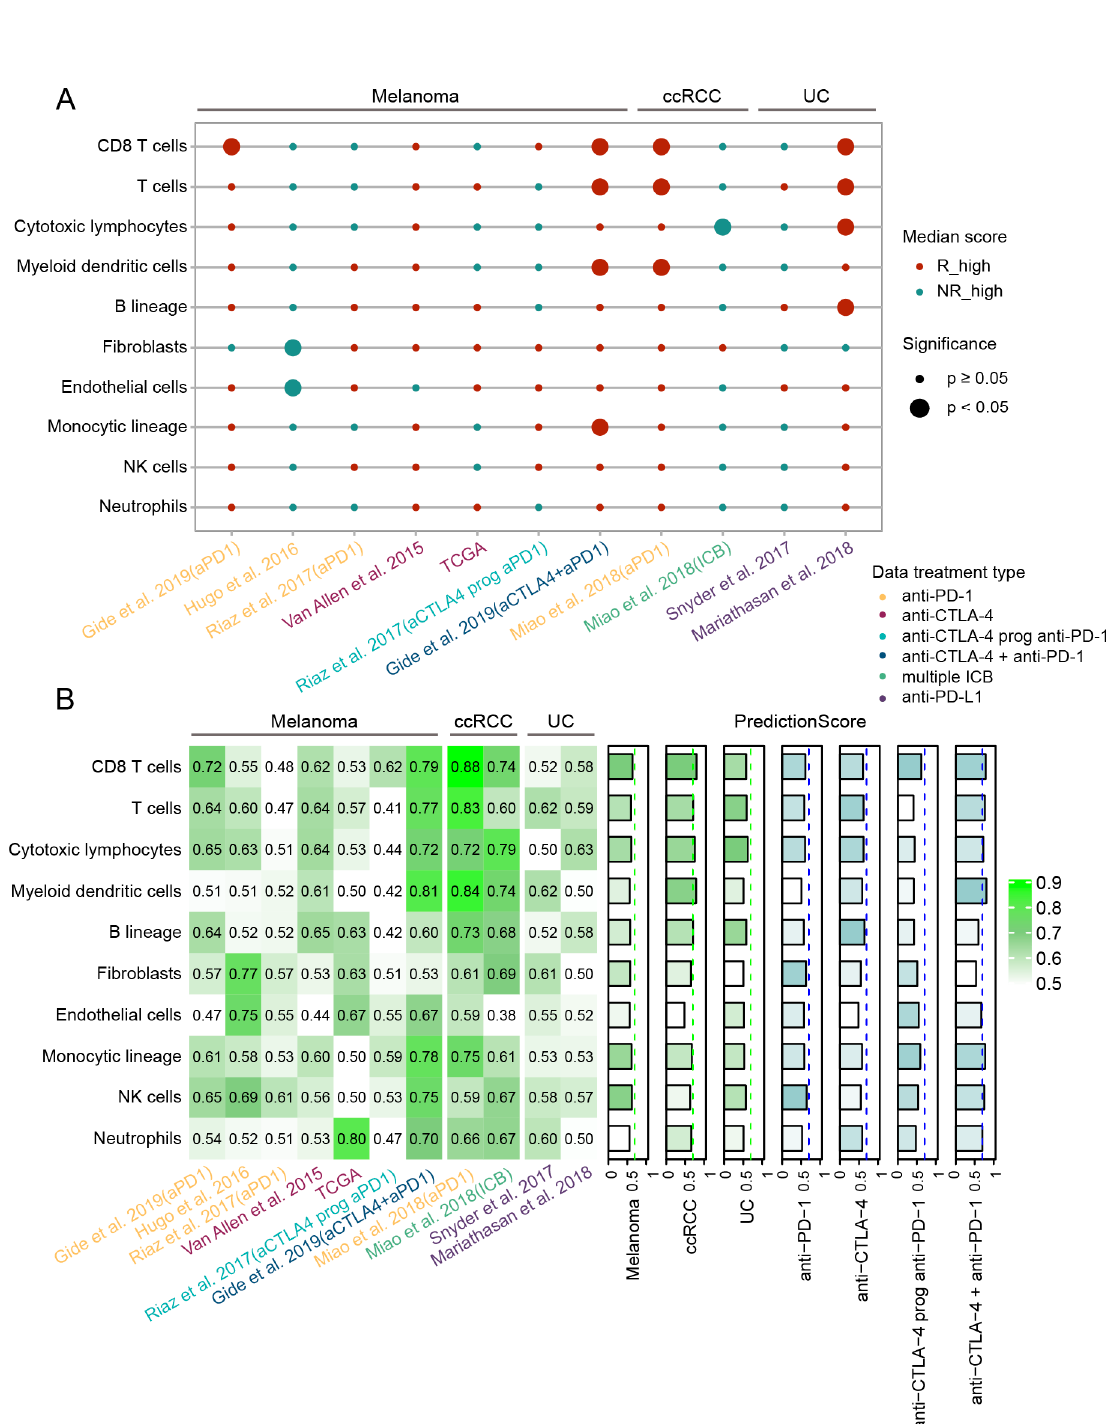
Figure 7. Evaluation of the association between the TME components and clinical response to ICB in different cancer types and therapies. ( A ) Scatterplot showed correlation of the abundance of TME components with ICB response in specific cancer type with different ICB therapy. Red dots denoted that the abundance of TME component was higher in responders than non-responders, green dots indicated the opposite. Size of dots indicated significance (larger for p < 0.05) and p value was computed by the two-sided Wilcoxon rank-sum test. Colors of different datasets indicated different ICB treatment strategies. ( B ) Prediction performance of each TME component for ICB response across different cancer and treatment types. AUC for each component across benchmark datasets were shown at left panel. The cancer type-specific and treatment type-specific prediction scores (sum of sample size-weighted AUC) were shown at right panel. The gradient of color indicated the prediction performance from low (light) to high